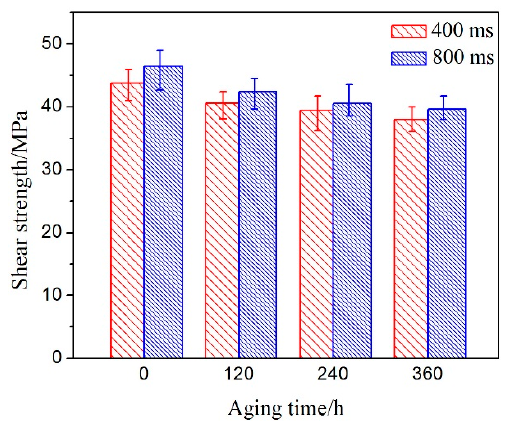
Figure 5. Shear strengths of joints after aging under different bonding times.